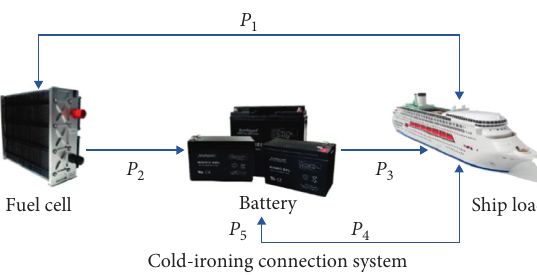
Figure 3: The topology of the fuel cell-battery-cold ironing.